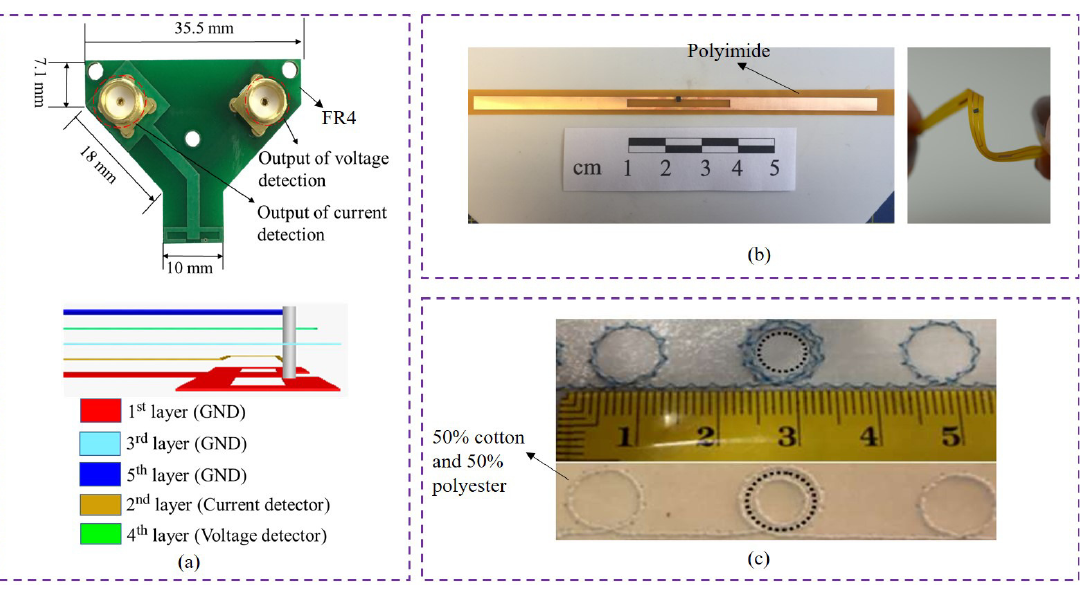
Figure 4. Three typical materials of the substrates. ( a ) Voltage and current sensor with FR4 substrate (adapted from [45]); ( b ) UHF-RFID tag with polyimide substrate (adapted from [40]); ( c ) UHF-RFID tag with 50% cotton and 50% polyester substrate (adapted from